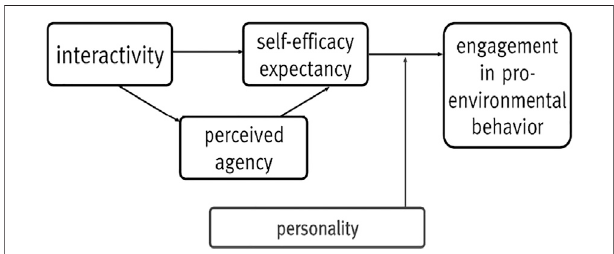
FIGURE 4 | One paradigmatic impact path resulting from use case 1.